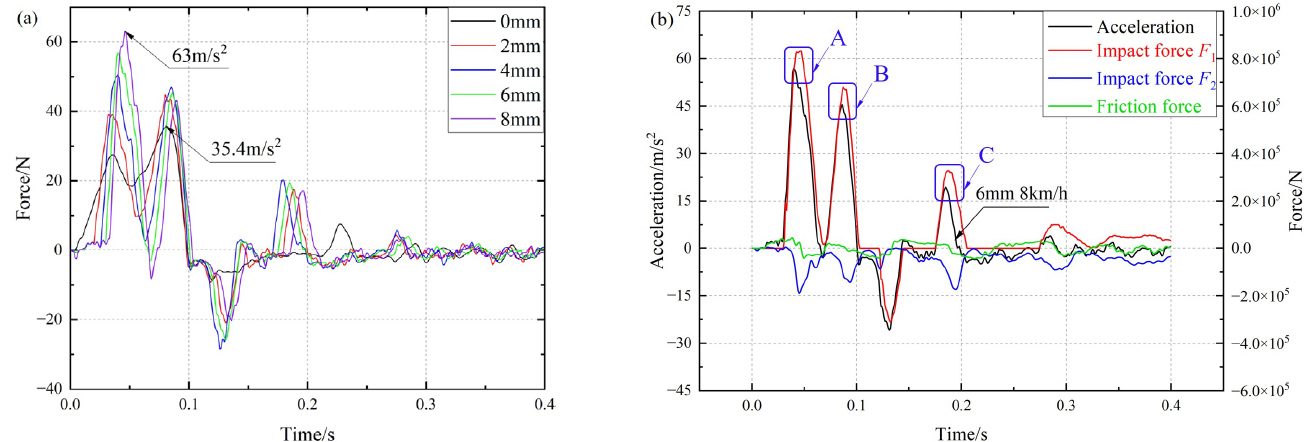
Figure 18. The variation of the tank container axial acceleration at the mass center over time: ( a ) at different initial clearance; ( b ) relationship with the F 1 , F 2 and friction force between corner fittings and the transport vehicle.